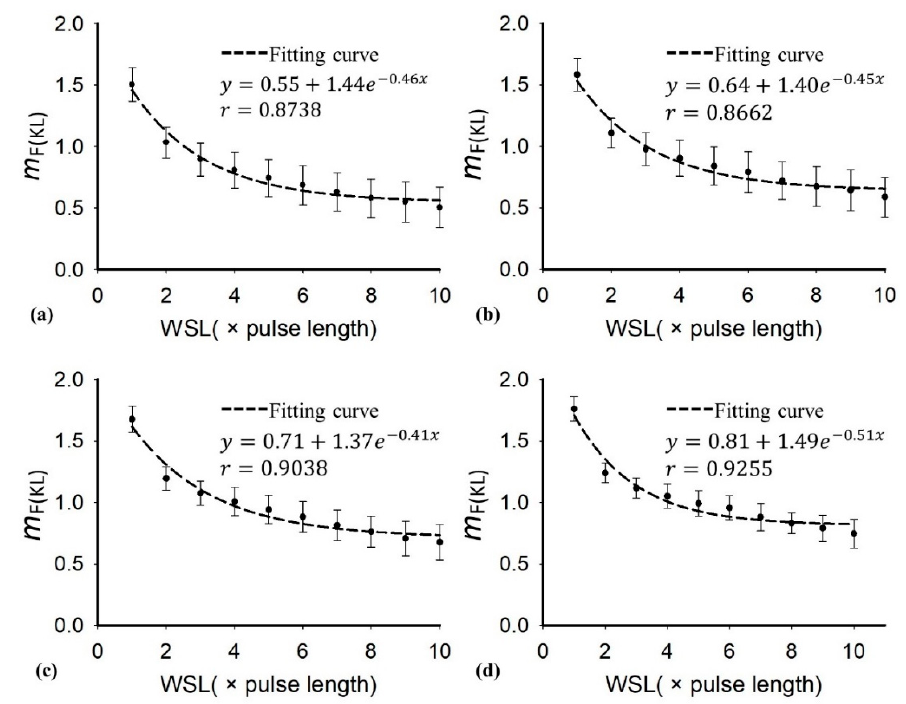
Figure 4. Average of the parameter m F(KL) in the region of interest (ROI) as a function of the window side length (WSL) obtained with different grades of hepatic steatosis: ( a ) normal; ( b ) mild; ( c ) moderate; ( d ) severe. As the WSL increased, the parameter m F(KL) gradually decreased to exhibit a relatively stable estimation.